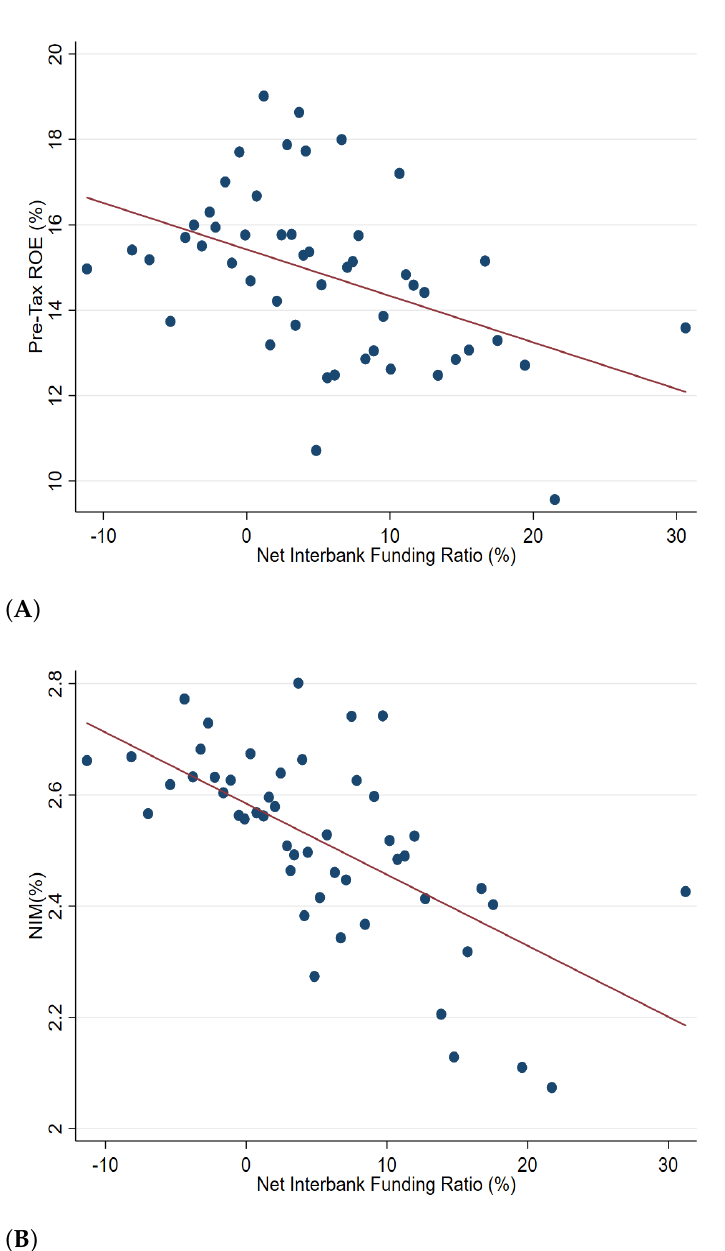
Figure 1. Bank Profit and Net Interbank funding Ratio. Notes: Subfigure ( A ) plots the relationship between pre-tax ROE and net interbank funding ratio. Subfigure ( B ) depicts the relationship between NIM, and net interbank funding ratio. The net interbank funding ratio is defined as the net interbank funding divided by the total liability. The interbank net interbank funding is calcuated as the interbank liabilities minus interbank assets. The interbank liability consists of overnight borrowing, PBOFI, and FA Repo. We deduct the interbank assets from the total liability to address the double counting issue. The sample includes 16 public listed banks. Data source: